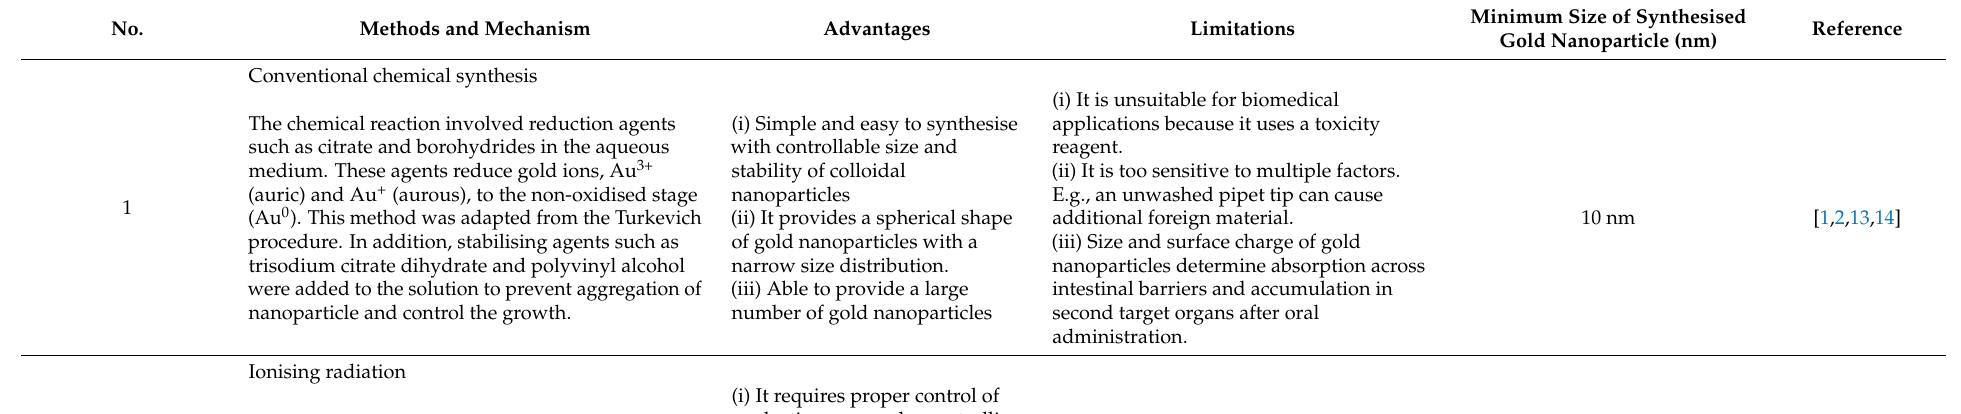
Table 1. A summary of gold nanoparticle synthetisation methods and mechanism, advantages and